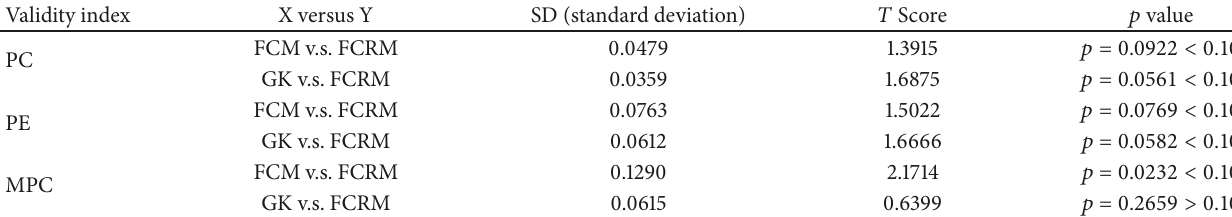
Table 7: Statistical results of the one-tailed 𝑡 -test ( 𝛼 = 0.10 ) on the differences using PC, PE, and